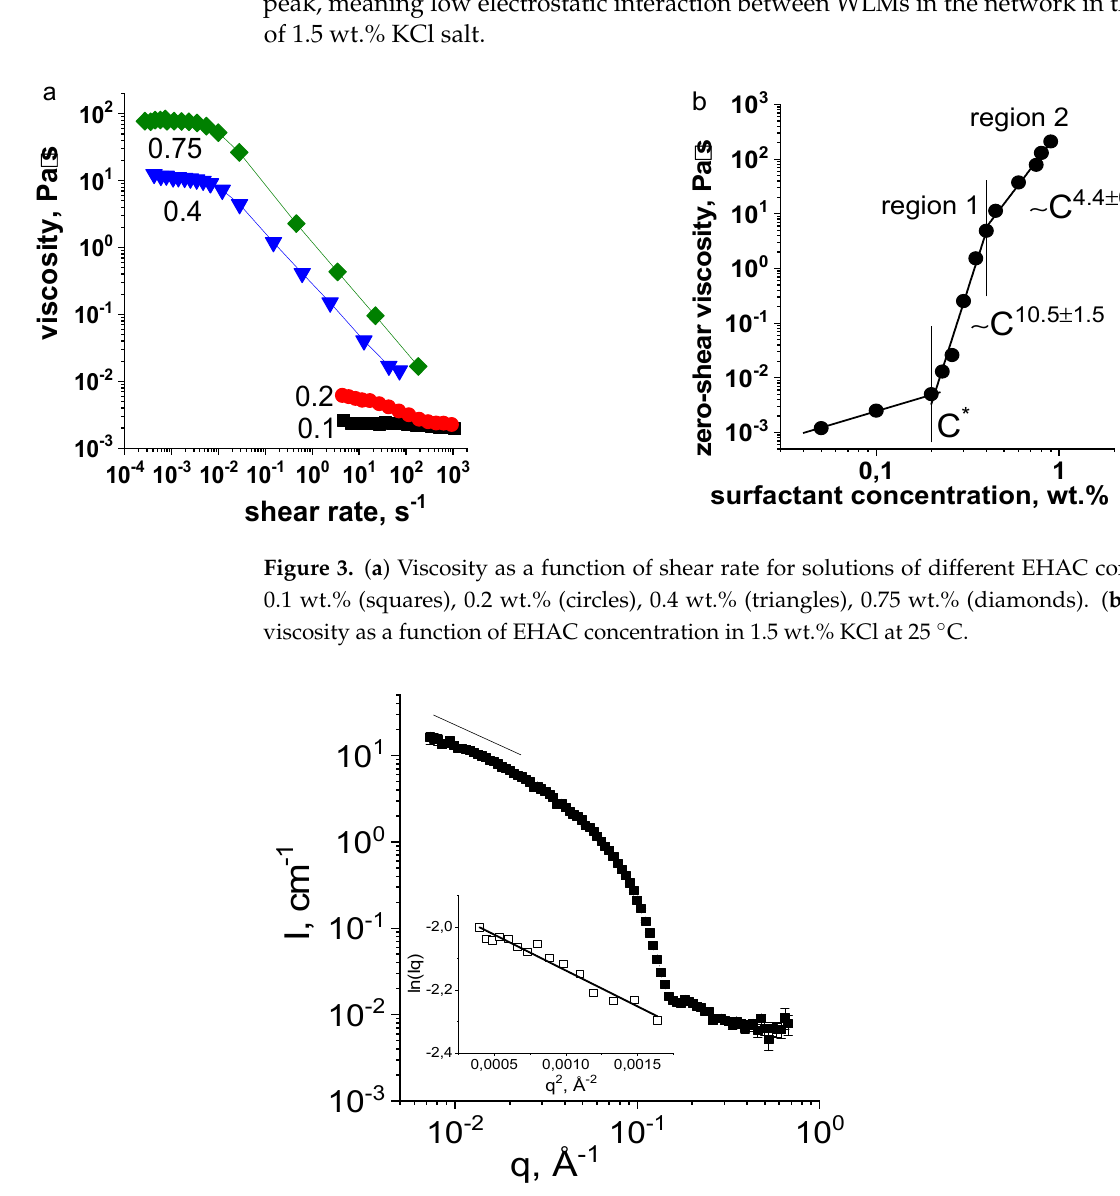
6 of 13 Figure 2. ( a ) Frequency dependencies of storage 𝐺 (cid:4593) (filled symbols) and loss 𝐺 (cid:4593)(cid:4593) (open symbols) moduli for 0.8 wt.% aqueous solutions of EHAC surfactant in the presence of 1 wt.% (circles), 1.5 wt.% (squares), and 5 wt.% (triangles) KCl at 25 °C. ( b ) Plateau modulus or storage modulus at high frequency (5 rad/s), ( c ) relaxation time, and ( d ) average contour length or effective contour length (for branched WLM) as a function of salt concentration for 0.8 wt.% aqueous solutions of EHAC surfactant. Further experiments were performed at fixed KCl concentration—1.5 wt.% (Debye screening lengths κ − 1 of 0.75 nm). At this concentration, the WLMs of EHAC are linear, and their contour length is 3 times smaller than the maximum length attained at 3 wt.% KCl (Figure 2d). One can expect that, at 1.5 wt.% KCl, the EHAC micelles will also remain linear at lower EHAC content because the transition from linear to branched WLMs always occurs with increasing surfactant concentration due to entropy reasons [12]. 3.2. Surfactant Concentration Dependencies Figure 3a shows the variation of the viscosity of the EHAC solutions with shear rate